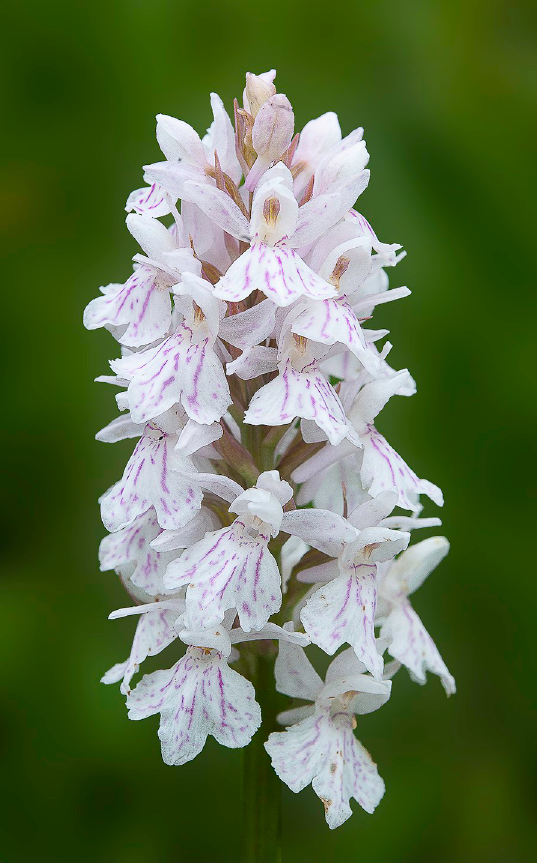
Fig 3. Dactylorhiza fuchsii (Druce) Soo´ subsp. sooana (Borsos) Borsos entire plant in its natural habitat (Fig 2), details of the inflorescences (Figs 3 and 4). One of the inflorescences (Fig 4) is visited by hoverfly of the family Syrphidae Latreille, 1802. The hoverflies, which are true bee-mimics, are very frequent visitors of D . fuschii subsp. sooana , although it has not been shown to be its real pollinators, as of yet. Figs 2–4 © 2020 N. Anghelescu originals.